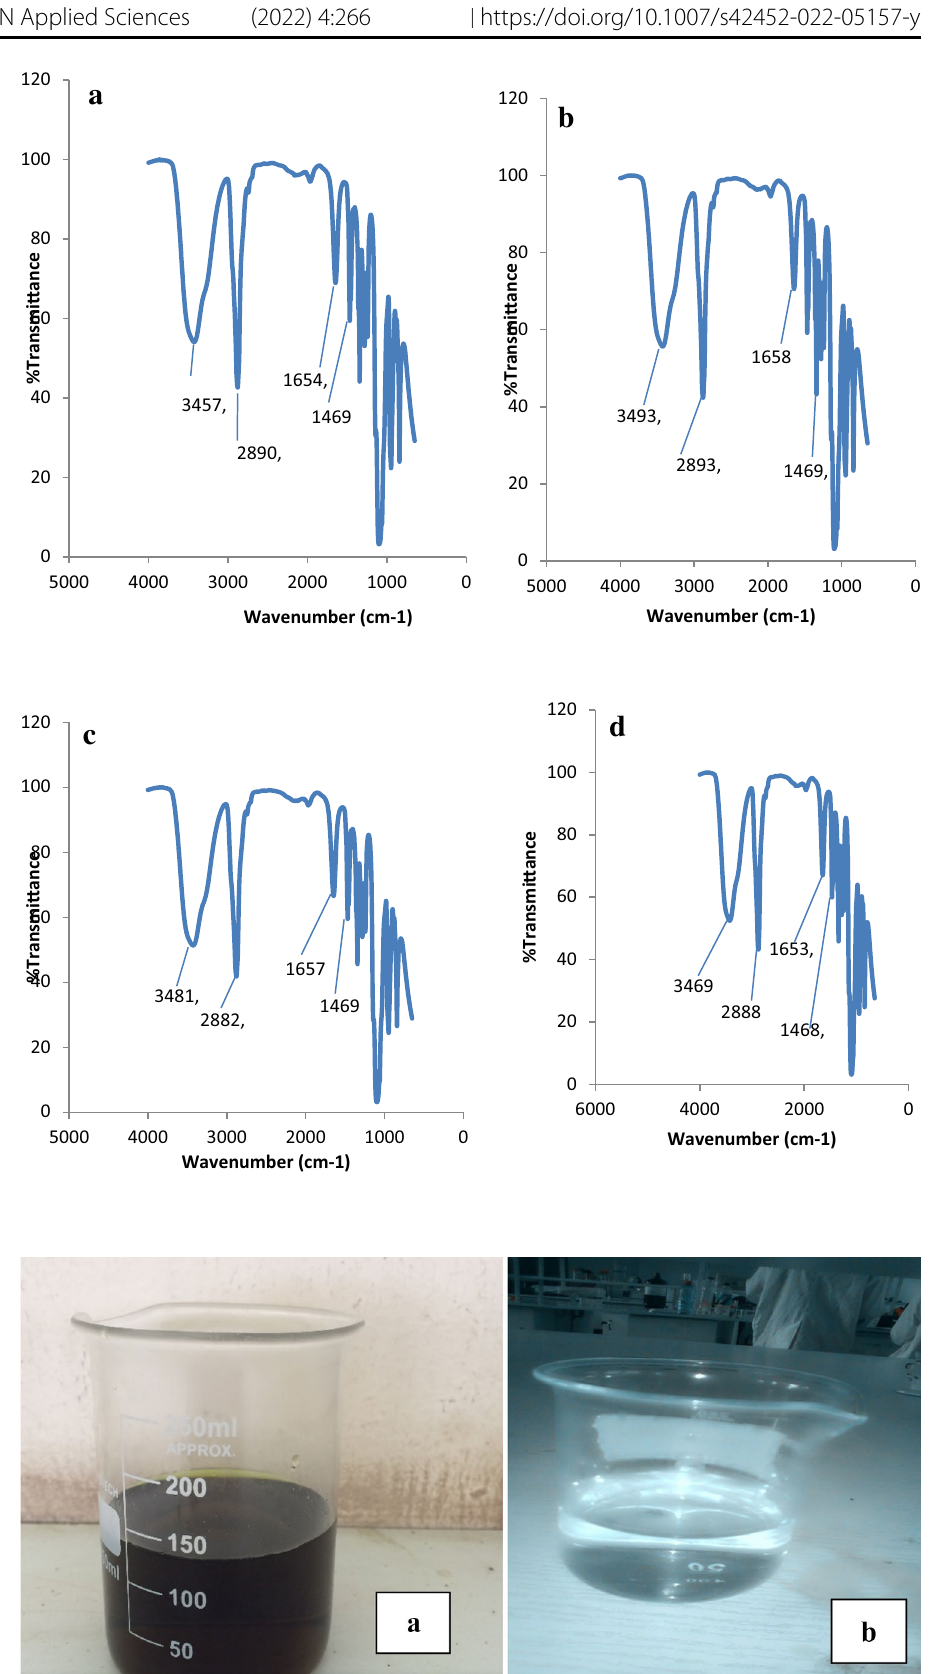
Fig. 4 FTIR spectral of biosyn- thesized a (SNP1); b (SNP2), c (SNP3); d (SNP4)